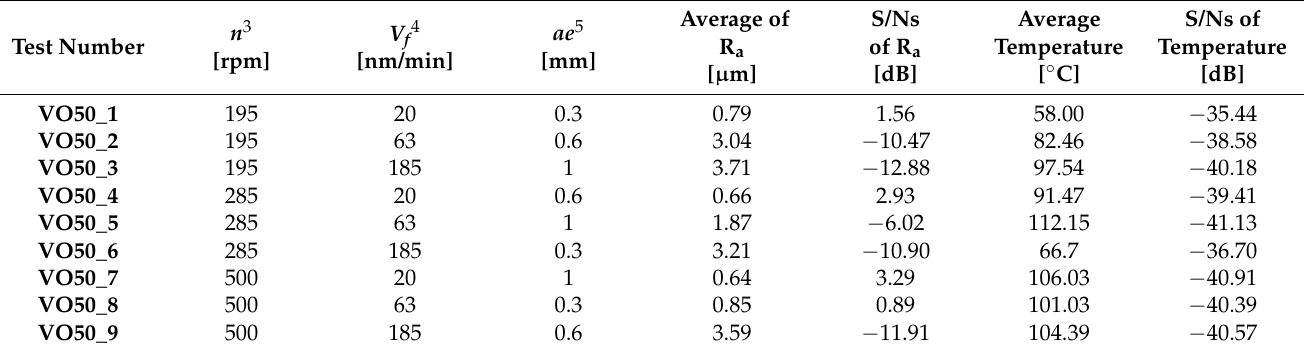
Table 9. Average surface roughness, average chip temperature values, and S/Ns ratios with vegetable oil (50